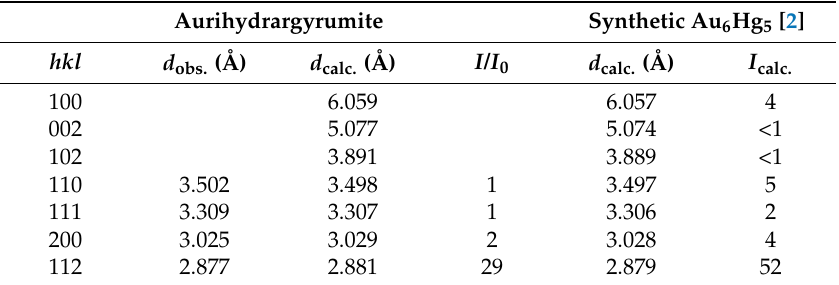
Table 2. Powder X-ray diffraction data (Cr K α radiation) for